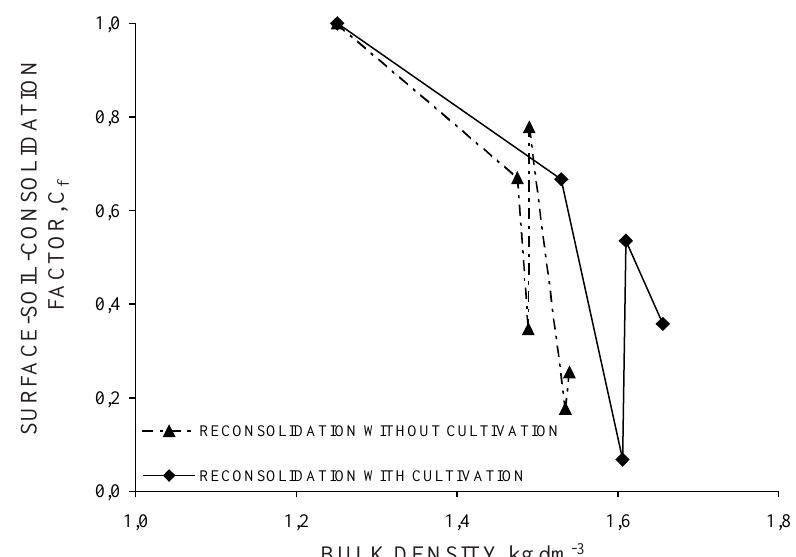
Figure 9. Surface-soil-consolidation factor as a function of bulk density in the reconsolidating soil